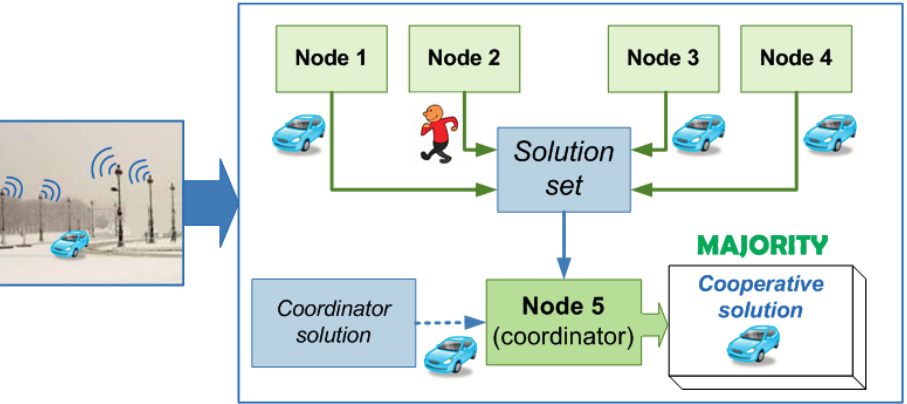
Figure 6. Majority-based voting.